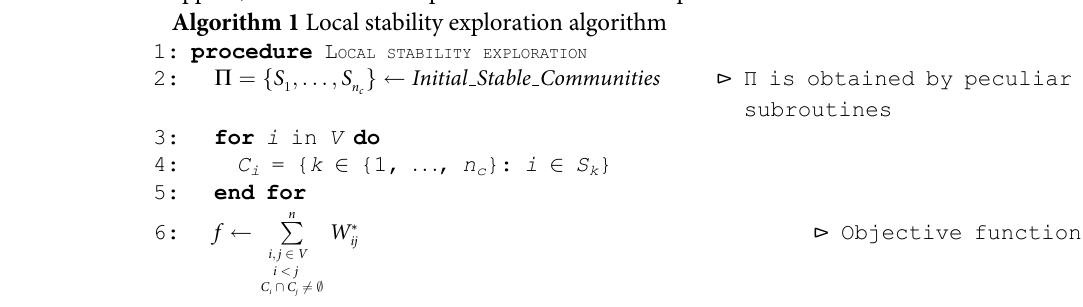
Algorithm 1 Local stability exploration